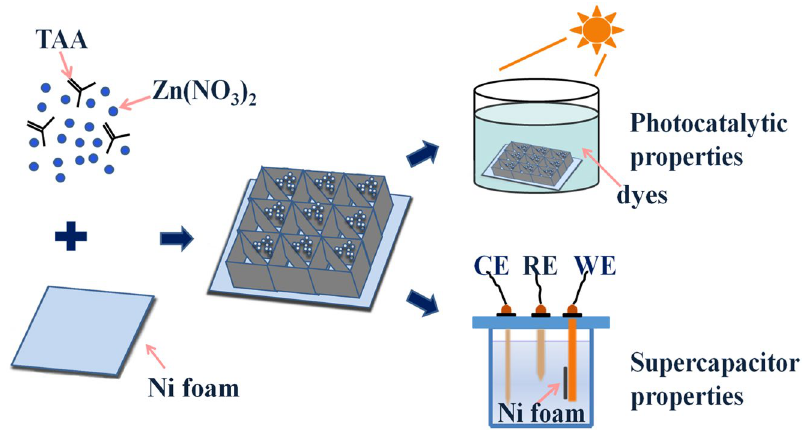
Figure 9. Schematic illustration of the formation mechanism of